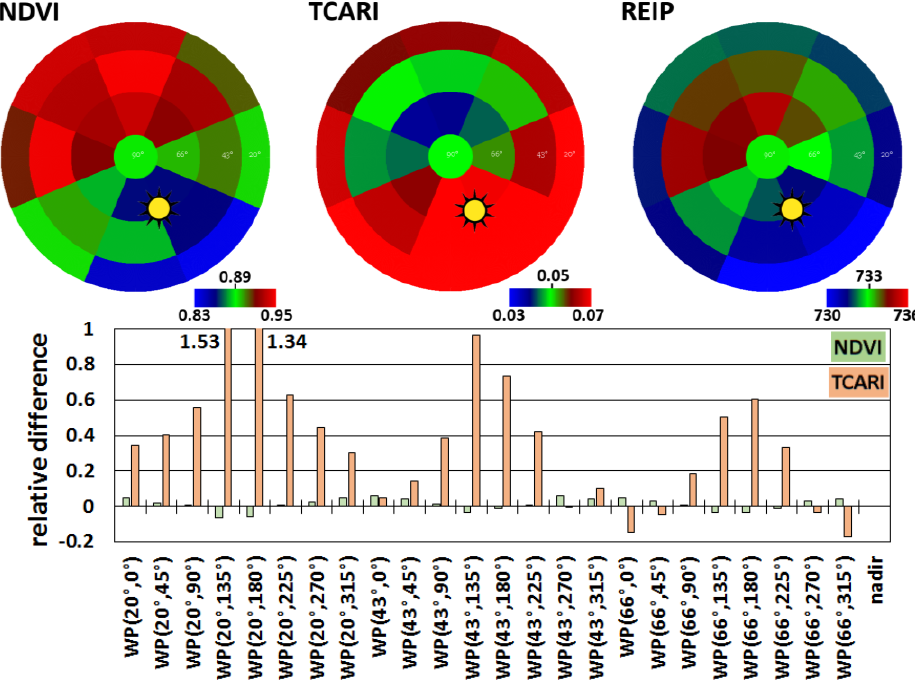
Figure 9. ( Top ) Absolute values for the NDVI, TCARI and REIP compared to the nadir value (center of the polar plot) for all waypoints of MERZ1. The range of values is chosen with nadir as center value, respectively, for each plot. Figure 5 details the angular arrangement depicted here. ( Bottom ) Relative differences for NDVI and TCARI compared to the nadir